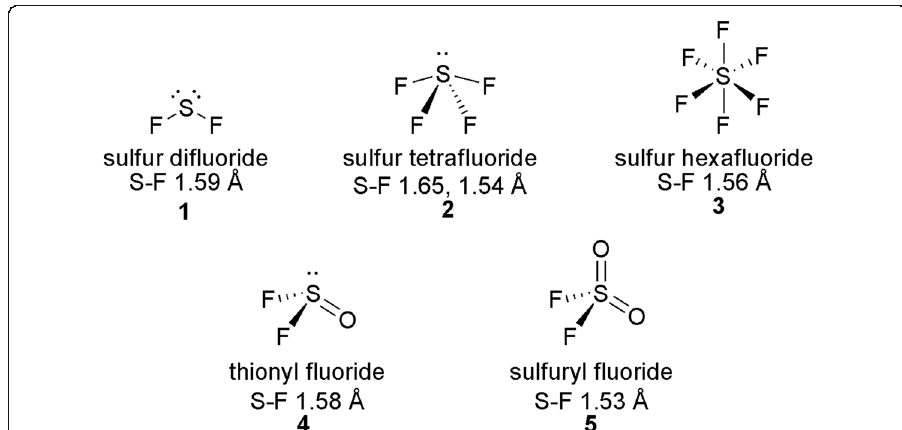
Fig. 1 S-F bond lengths in different model